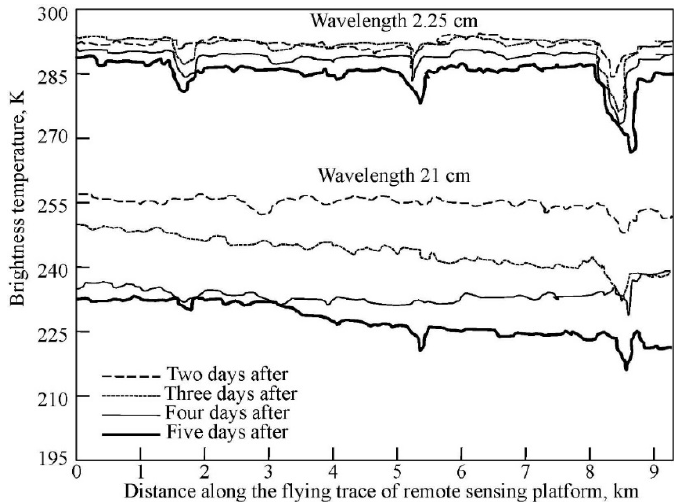
Figure 8. Spatio-temporal variation of brightness temperature with time after rainfall. Measurements were made from August 10, 2007 when it was raining (15 mm). Table 6. Soil-litter moisture (%) dynamics after rainfall. The s oil-litter thickness is 10.7 cm. The water drainage factor to soil is 0.7. The canopy interception coefficient is 0.2. The measurements were carried out in 2003–2008 during the Russian–USA and Russian–Bulgaria ecological missions [29,38,57]. Rainfall, cm Days after rainfall